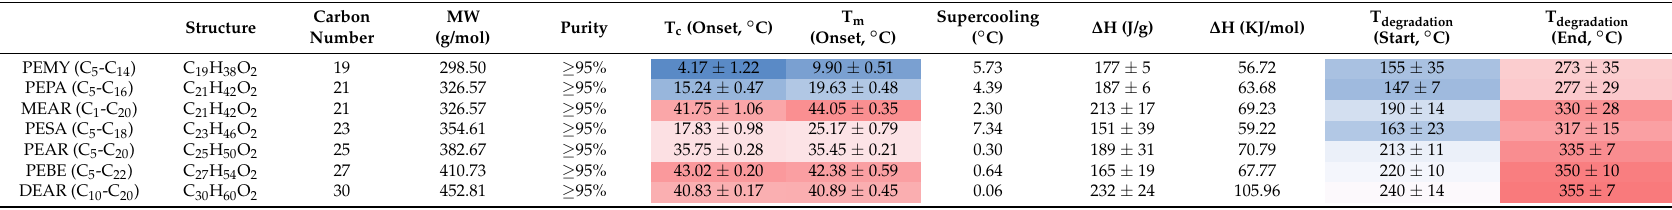
Table 3. Summary of thermal properties of the ester produced. Esters are ordered for increasing carbon number. The colors indicate the temperature gradient from the lowest values (blue) to the highest (red). A trend between degradation temperatures and molecular structure is observed, with progressive growth of the thermal stability together with carbon chain length. All ∆ H (J/g) values registered were over 150 J/g, confirming the fatty acid esters’ suitability as PCM.